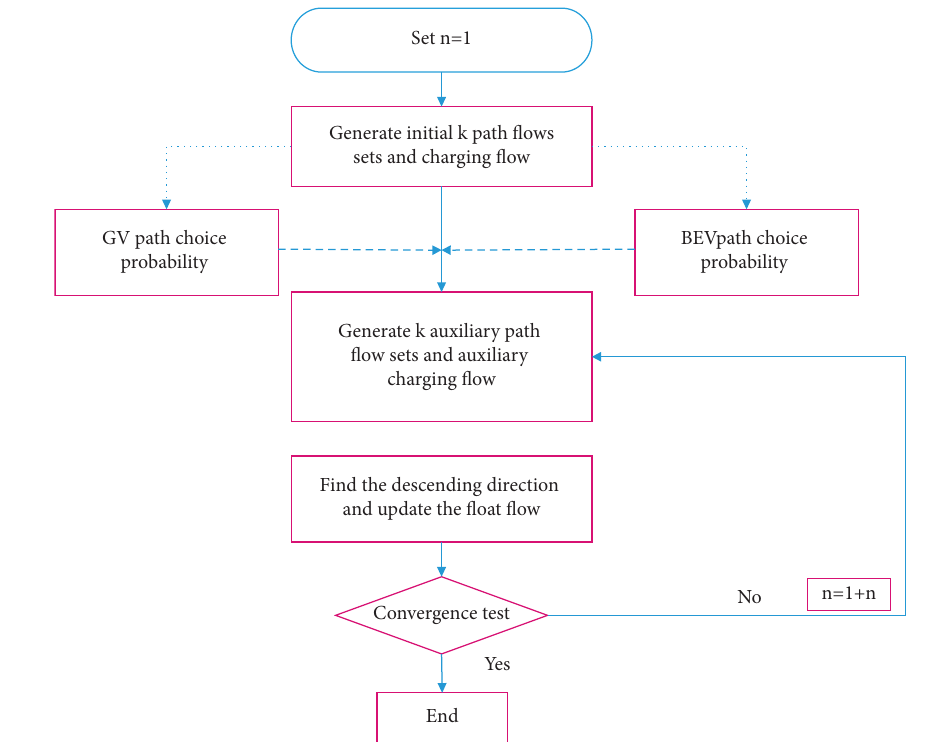
Figure 2: Flowchart for MSA-LSUE-RCB algorithm.